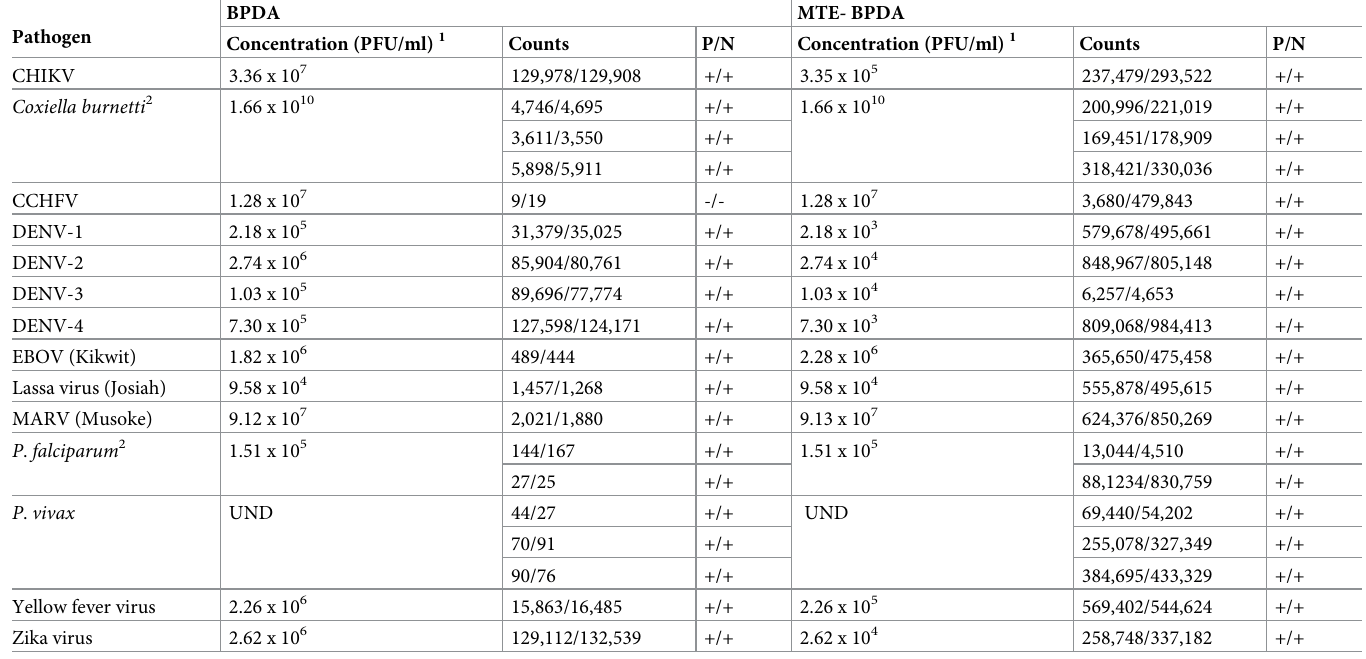
Table 1. Selected pathogen detection with and without MTE.